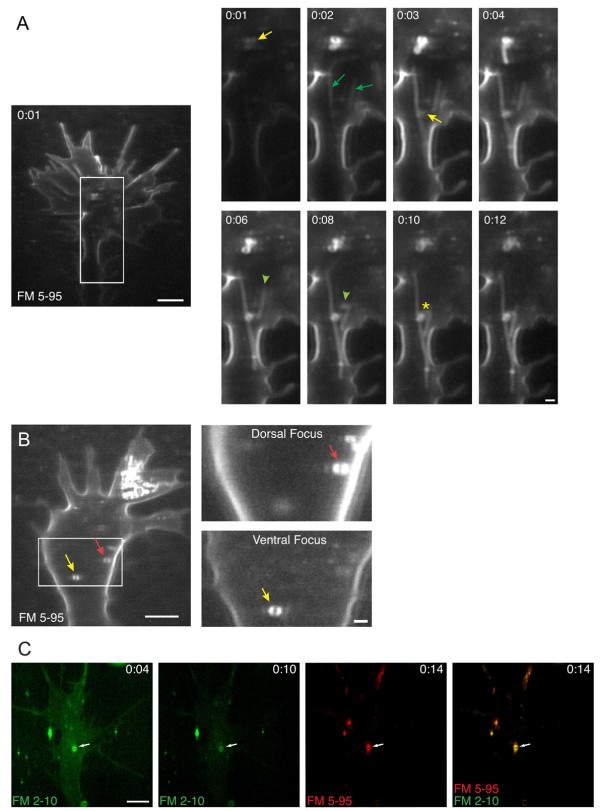
Endocytic tubules and vacuoles in the growth cone central domain. (A) Time-lapse confocal images of FM 5-95 internalization show dye incorporation into elongated tubules (green arrows, 0:02) and vacuoles (yellow arrows, 0:01 to 0:03) that correspond to the timing of surface membrane labeling. Tubules (green arrowheads, 0:06 to 0:08) and vacuoles are most often stationary but occasionally become motile and contact one another (yellow asterisk, 0:10 to 0:12). See Additional file 13 for the corresponding time-lapse movie. (B) Confocal images show FM 5-95 labeled vacuoles associated with dorsal (red arrow) and ventral (yellow arrow) surface membranes. The boxed region on the left is magnified at the right, which shows two different confocal z-sections of the same growth cone. Dye-labeled vacuoles are either seen in the dorsal (upper magnified panel) or ventral (lower magnified panel) confocal sections of the growth cone. The numerous vesicles in the upper-right lamellipodium of the far left panel originated from small vesicle hot-spots. Scale bars, 5 μm (left), 1 μm (right). (C) Time-lapse confocal images show that FM dye-labeled vacuoles are continuous with the plasma membrane for extended time periods. The time (minutes:seconds) following the initial dye pulse is indicated in each frame. In this modified dual-labeling assay, a first micropipette delivered a focal pulse of FM 2-10 at 0:00 (green, left panel), which rapidly labels several small vesicles and a vacuole (0:04, white arrow). A subsequent pulse of FM 5-95 (red), applied from a second micropipette at 0:12, incorporates into the same vacuole (0:14, white arrow). Scale bar, 5 μm.